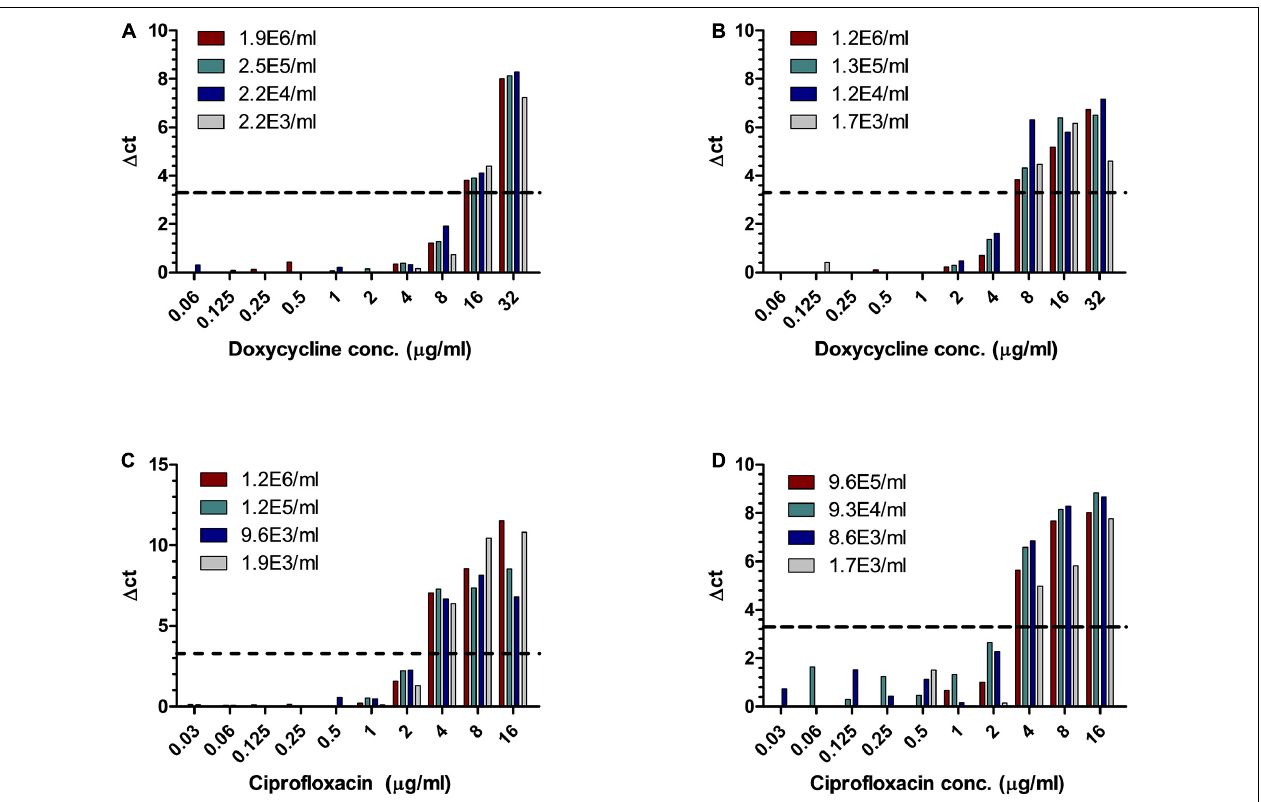
FIGURE 4 | MIC determination of blood cultures and whole blood samples inoculated with Y. pestis derivatives with reduced susceptibility to doxycycline and ciprofloxacin. Human blood cultures (A,C) and whole blood samples (B,D) , inoculated with different concentrations of Y. pestis derivatives (cfu/ml) with reduced susceptibility to doxycycline (A,B) and ciprofloxacin (C,D) , were subjected to AST for ciprofloxacin and doxycycline, by the MAPt analysis. MICs were determined, as described in the Materials and Methods section, by the threshold (cid:49) CT =